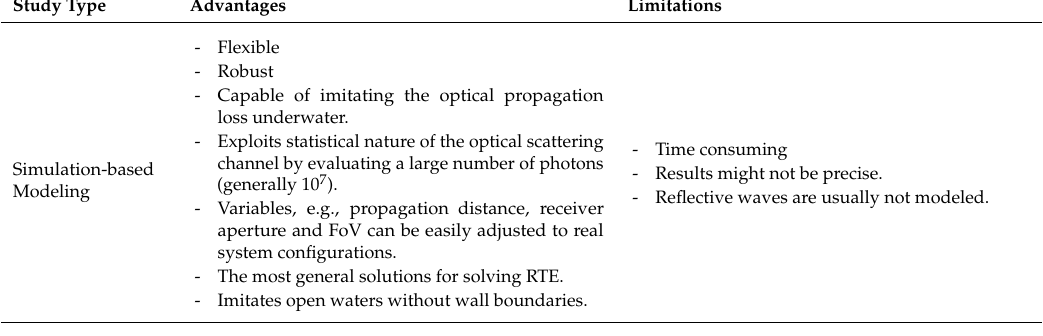
Table 1. Summary of the advantages and limitations of the three types of evaluation